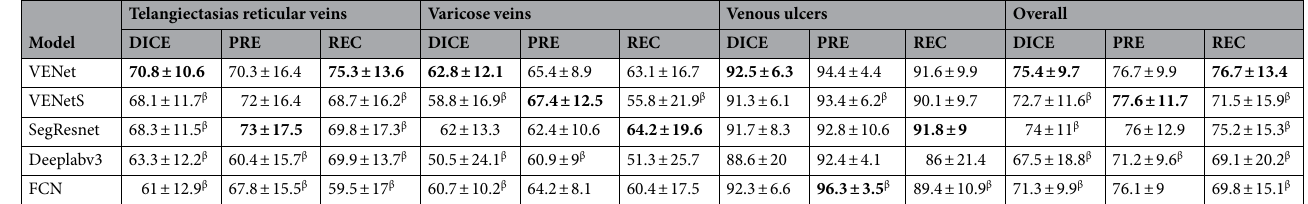
Table 4. Comparison of the VENet performance against conventional DCNN for the CVD segmentation task. The results for the segmentation of each studied CVD lesion are presented separately. Moreover, the overall column presents the average of the individual lesion results (mean ± S.D.) β p < 0.05, Paired t test against the proposed VENet strategy. Bold values indicate best